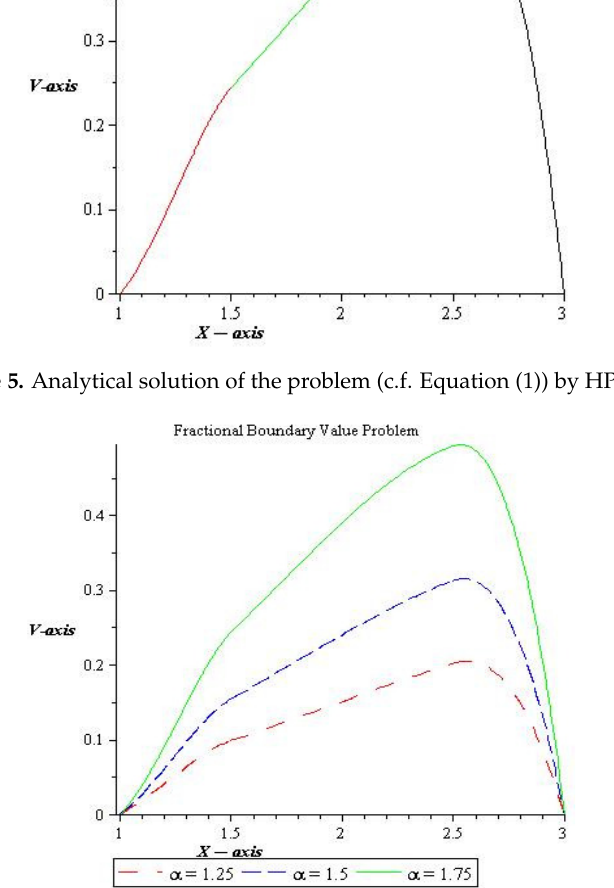
Figure 6. Analytical solution of the problem (c.f. Equation (1)) for different values of α by using